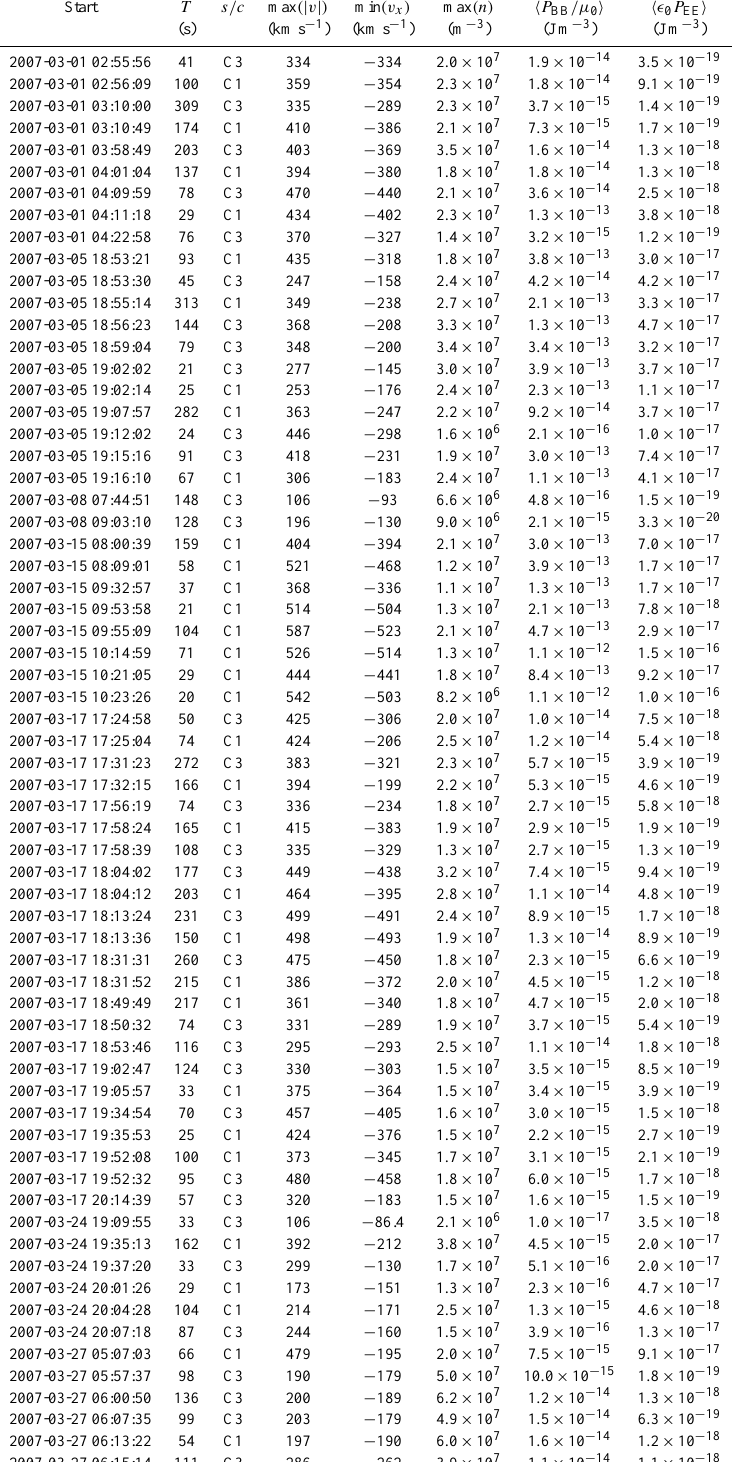
Table 1. Plasmoids identified in the data from March 2007. The columns show the first time that the plasmoid was observed; its duration T ; the spacecraft that observed it; the maximum value of the plasma speed, max ( | v | ) , within the plasmoid; the most negative v x value; the maximum density max (n) ; and the mean energy density of the magnetic h P BB /µ 0 i and electric h (cid:15) 0 P EE i fluctuations in the frequency range 10Hz ≤ f ≤ 500Hz, measured by the STAFF